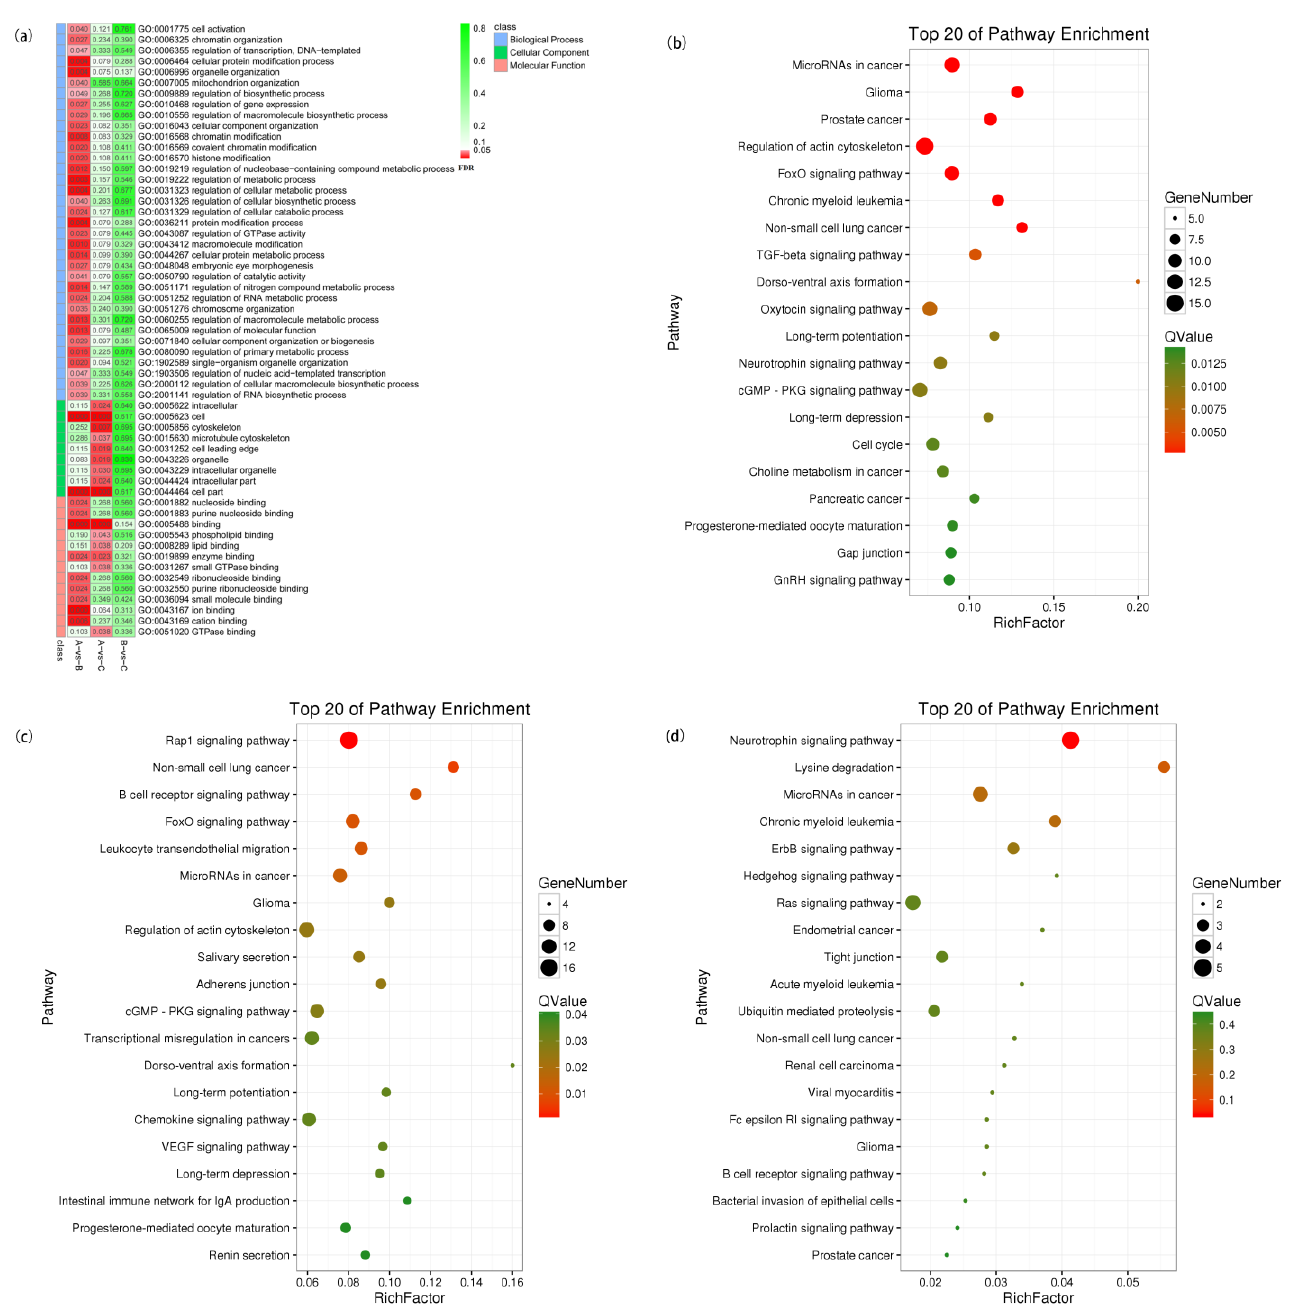
Figure 6. GO and KEGG enrichment analyses of DEcircRNA-hosting genes between different groups.( a ) GO. enrichment analysis of DEcircRNA-hosting genes. ( b ) KEGG enrichment analysis of DEcircRNA-hosting genes between group A and B. ( c ) KEGG enrichment analysis of DEcircRNA hosting genes between group A and C. ( d ) KEGG enrichment analysis of DEcircRNA hosting genes between group B and C.